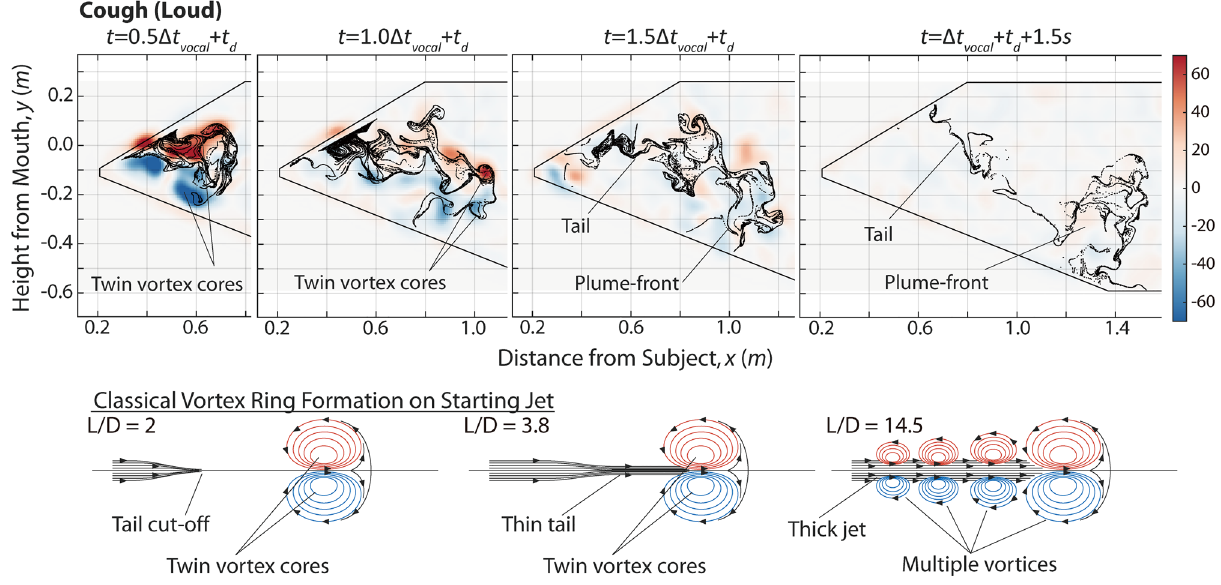
Figure 2. Dispersion dynamics of aerosol particles for a loud cough. Background: vorticity in s −1 . Inset: illustration of a classical vortex ring formation process from an impulsively-started jet 25 for